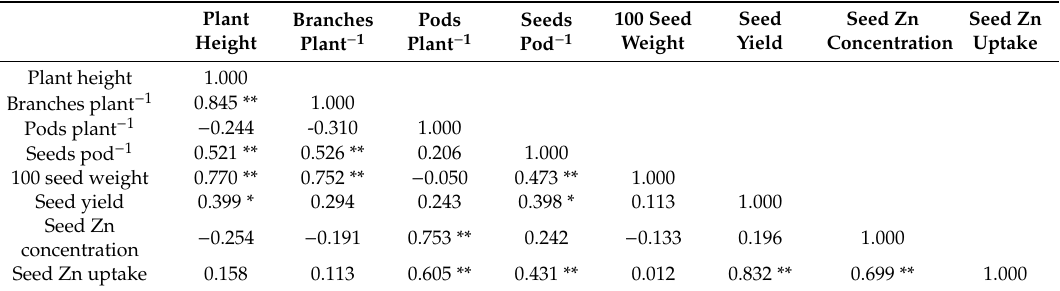
Table 4. Pearson’s correlation coefficients showing relations among plant height, branches plant − 1 , uptake of pigeonpea genotypes (n = 38). *, ** denote significant at p < 0.05 and p < 0.01, respectively. Plant Branches Pods Height Plant − 1 Plant − 1